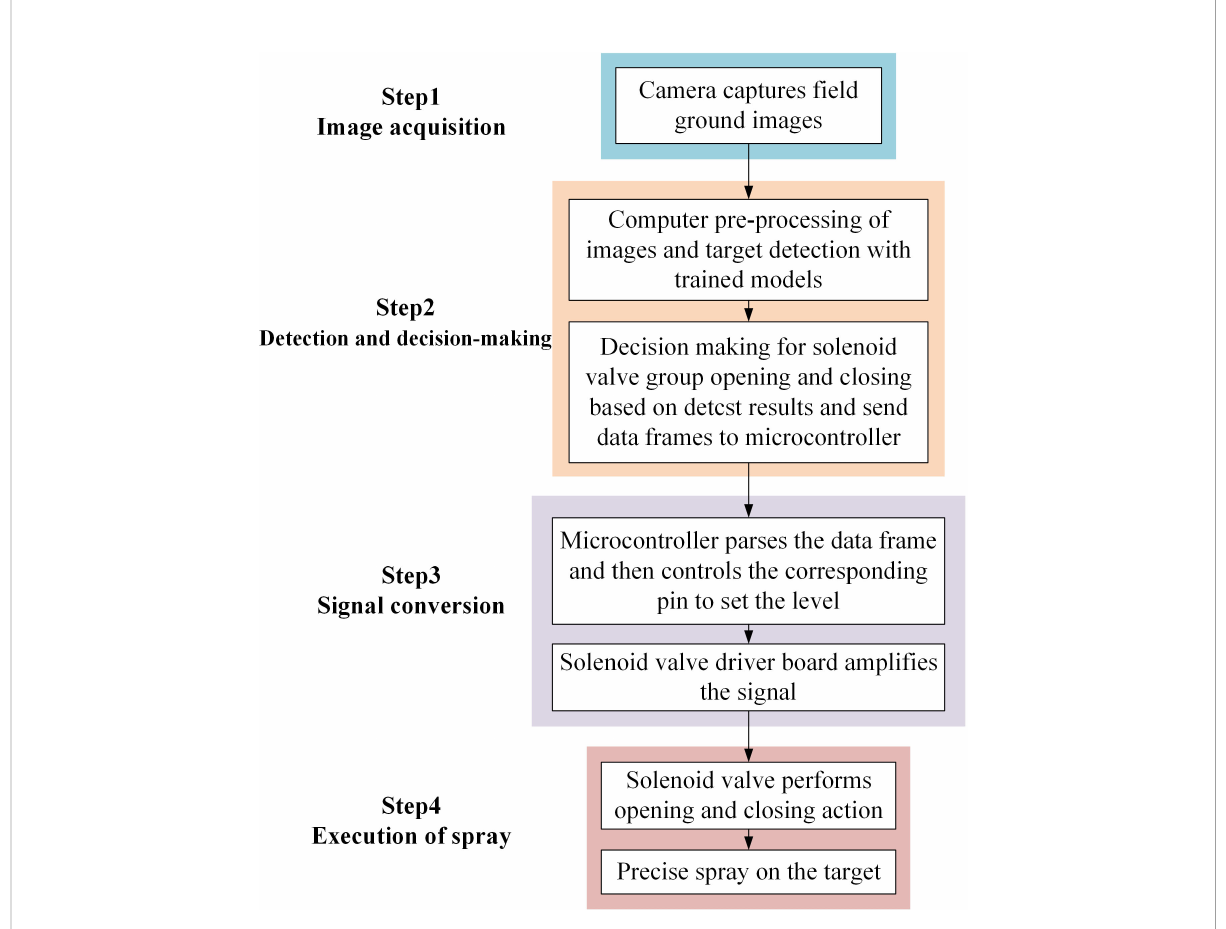
FIGURE 3 The system work fl ow block